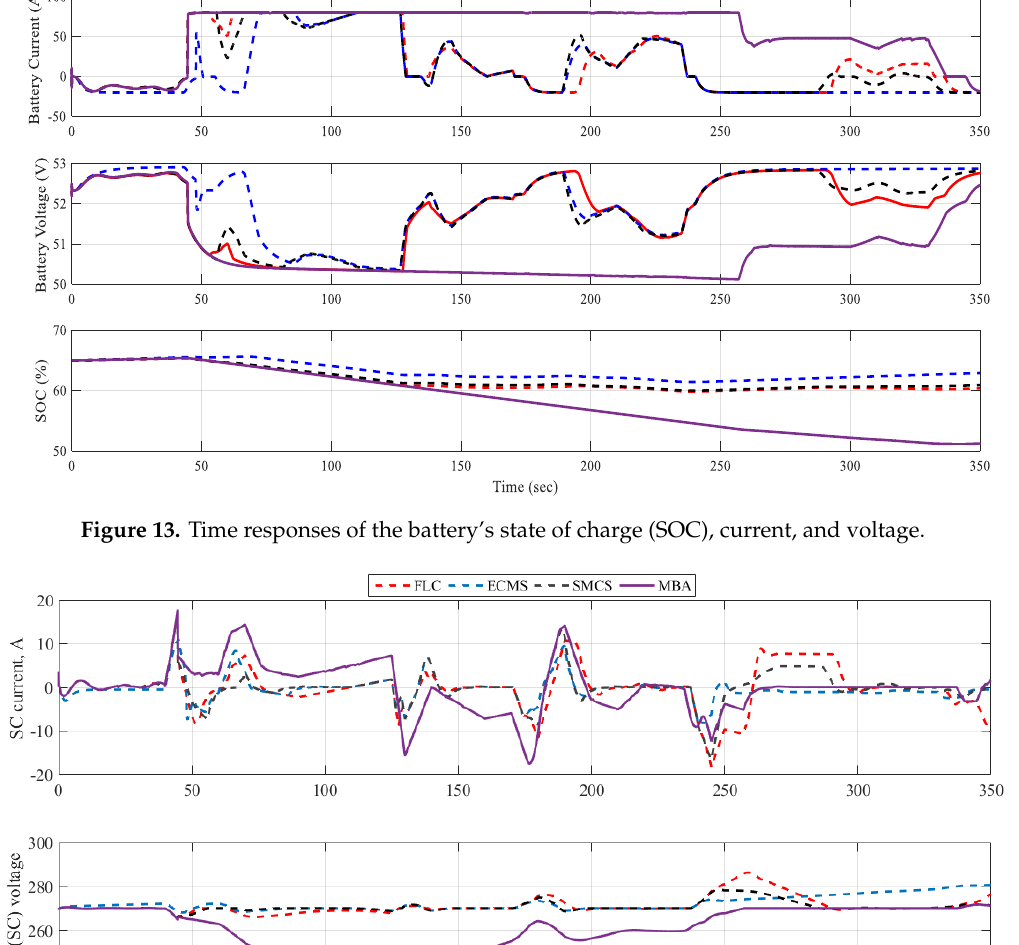
Figure 12. Variation of load and generation powers with time.